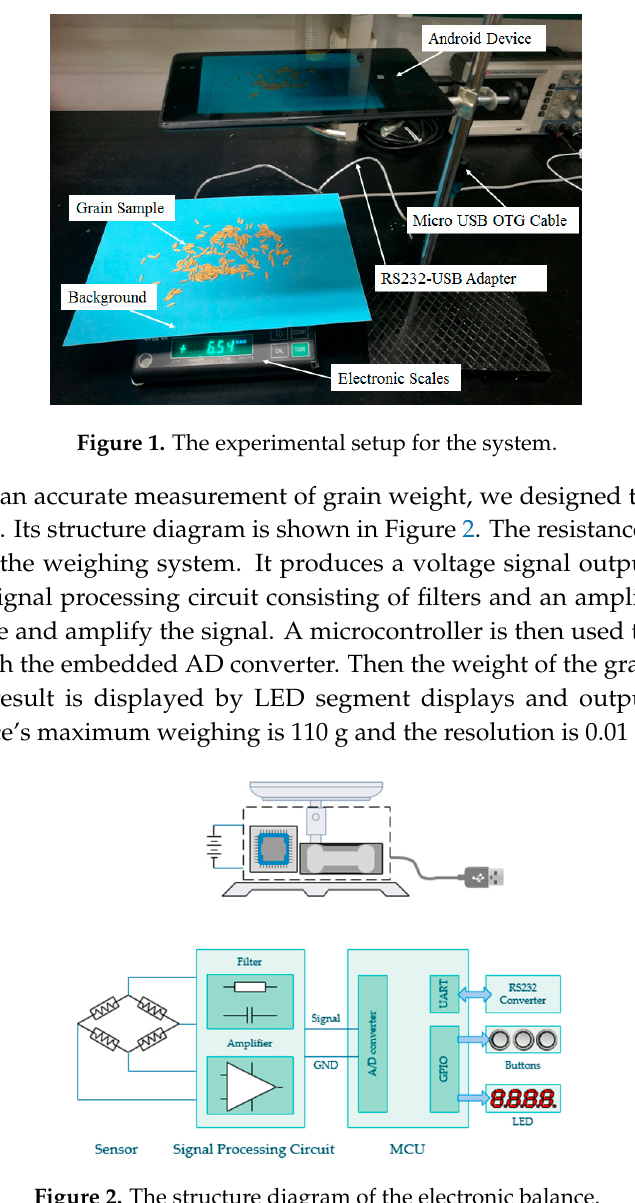
Figure 2. The structure diagram of the electronic balance.